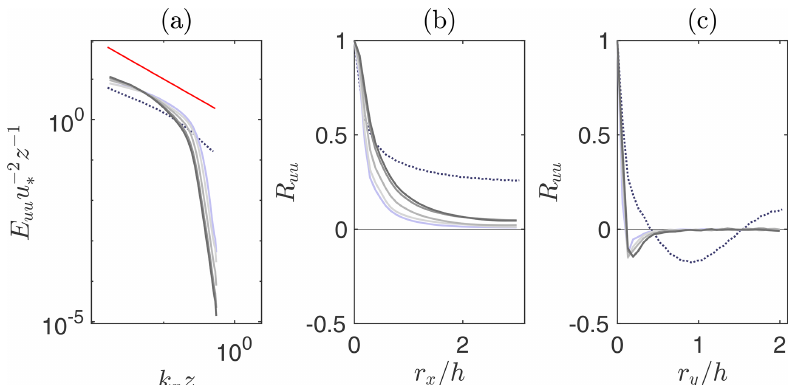
Figure A2. Normalized one-dimensional spectra of streamwise velocity at z/h ≈ 0 . 1 (a) ; one-dimensional spatial autocorrelation of stream- wise velocity at z/h ≈ 0 . 1 along the streamwise direction (b) and along the cross-stream direction (c) . Lines as in Fig. A1. The red line denotes (k x z) − 1 .